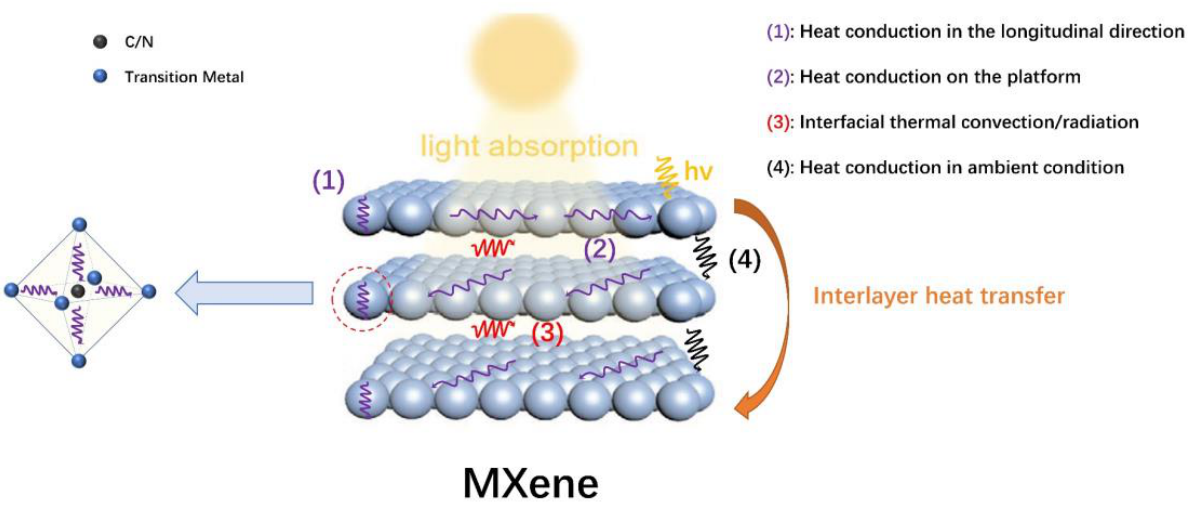
Figure 4. Schematic illustration of the structure and the mechanism of heat transfer process of MXenes.